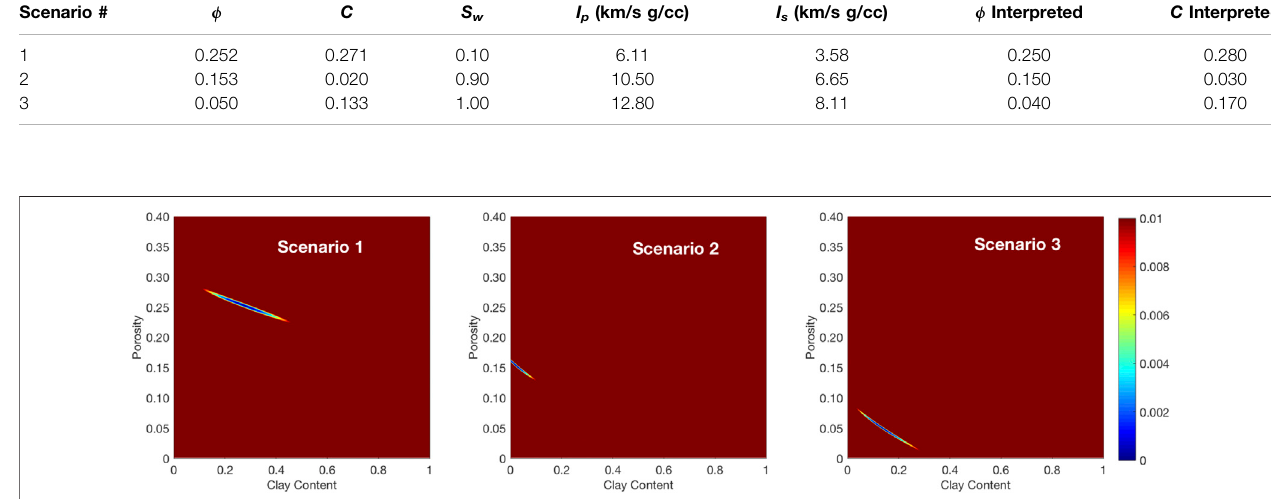
Frontiers in Earth Science |